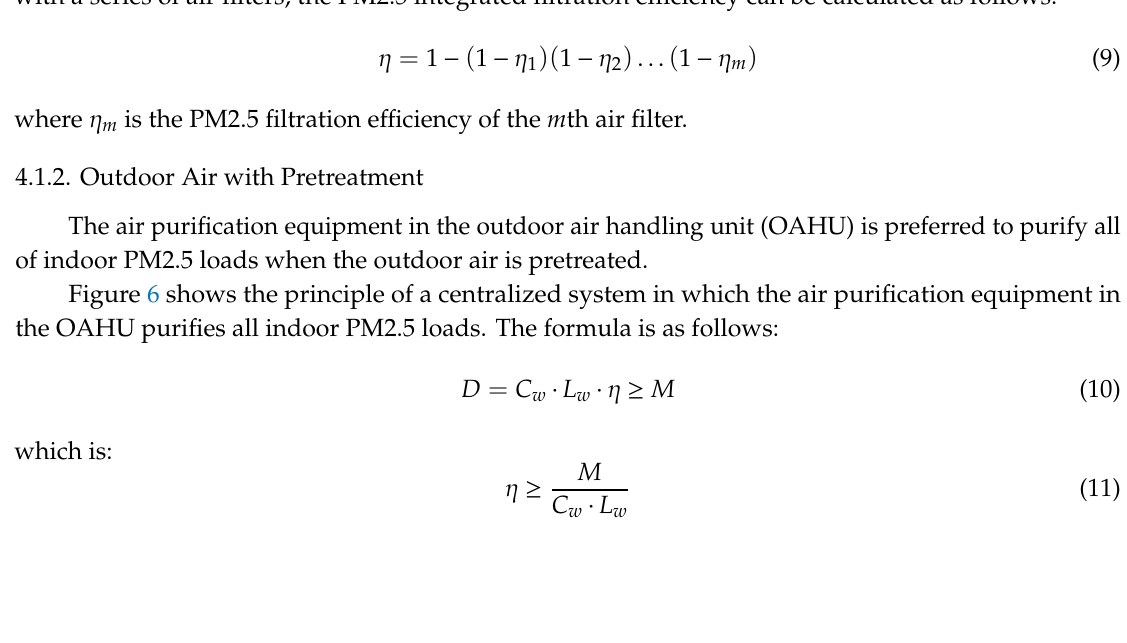
Figure 6. Schematic diagram of a centralized system with outdoor air pretreatment and purifying indoor PM2.5 load. Figure 6 shows the principle of a centralized system in which the air purification equipment in the OAHU purifies all indoor PM2.5 loads. The formula is as follows: w